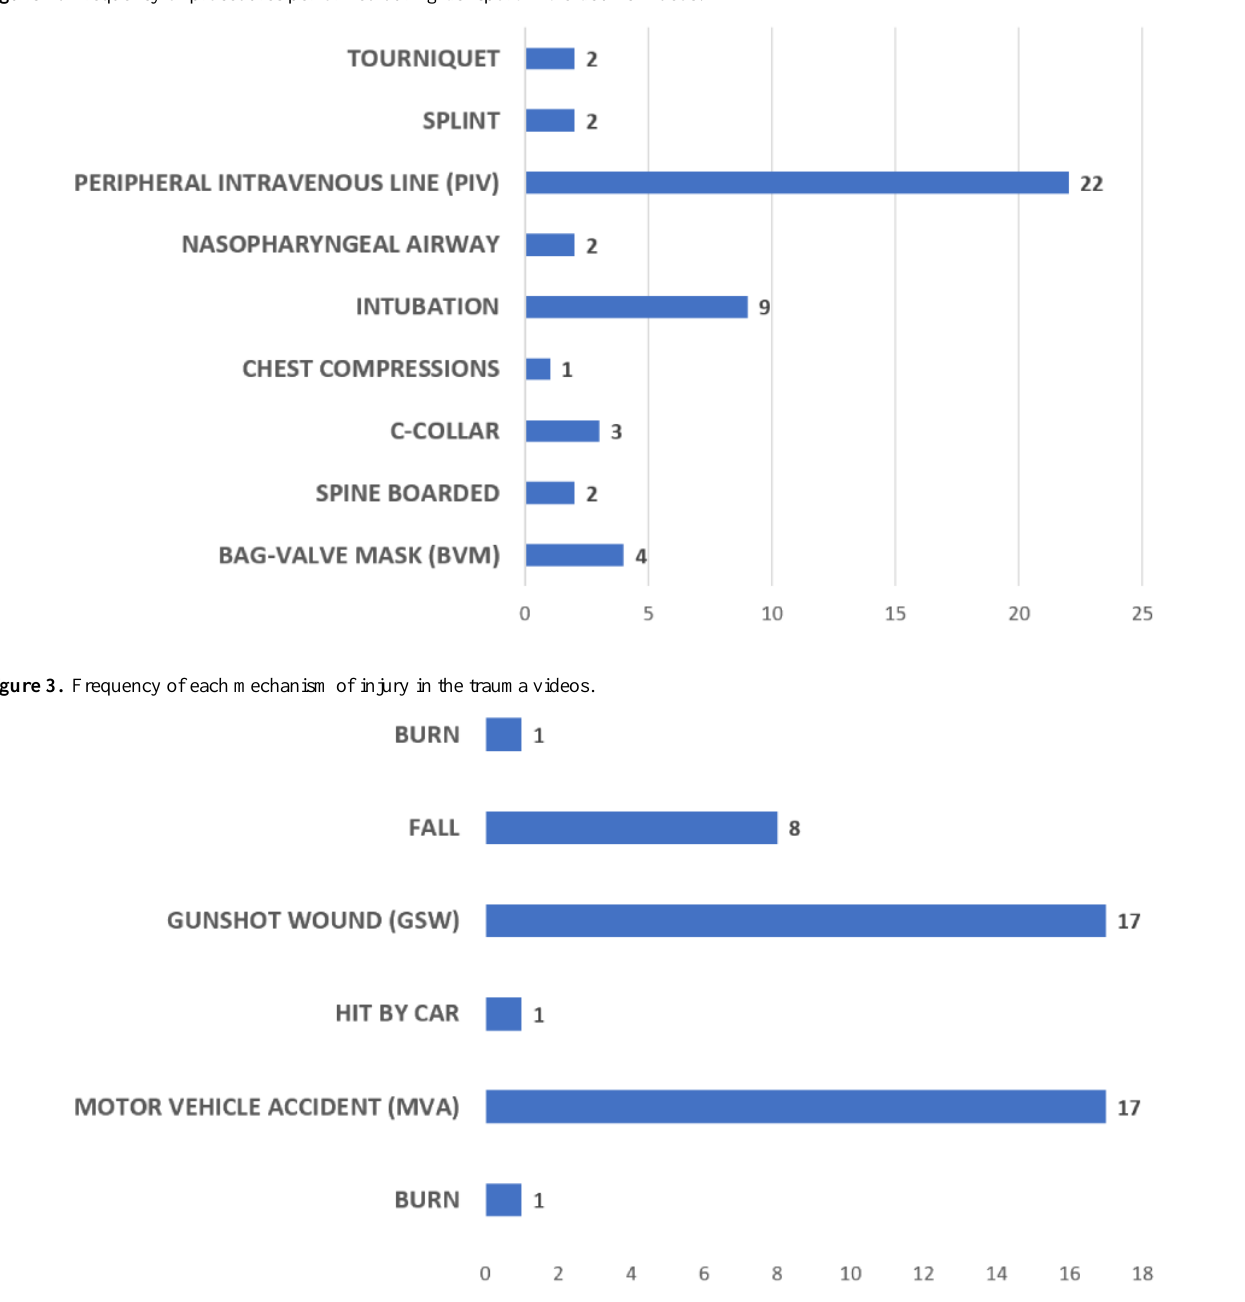
Figure 2. Frequency of procedures performed during transport in the trauma videos.